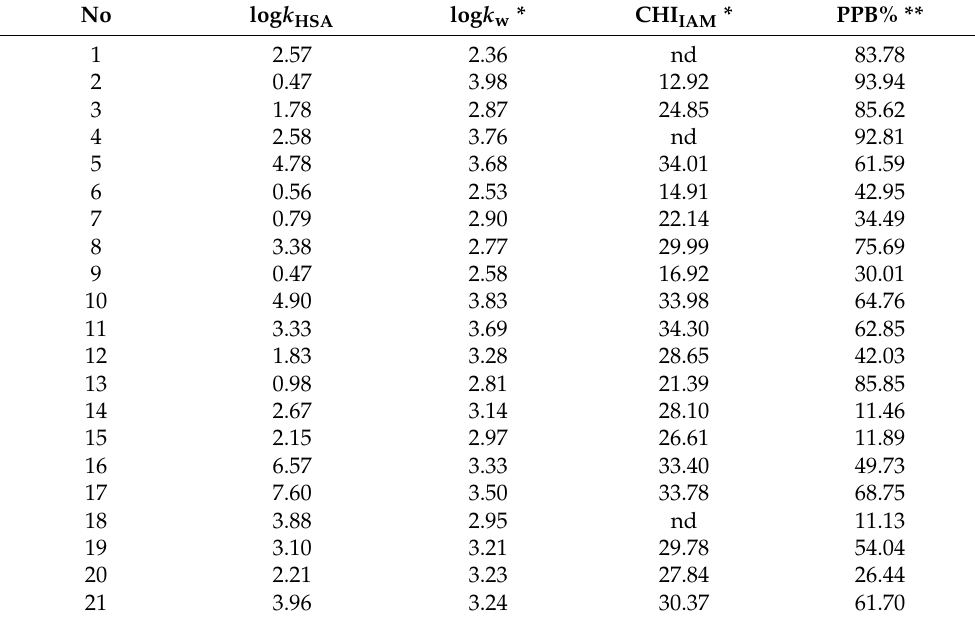
Table 1. Chromatographically determined log k HSA parameters, lipophilicity indexes (log k w ) and affinity to phospholipids (CHI IAM ) along with calculated